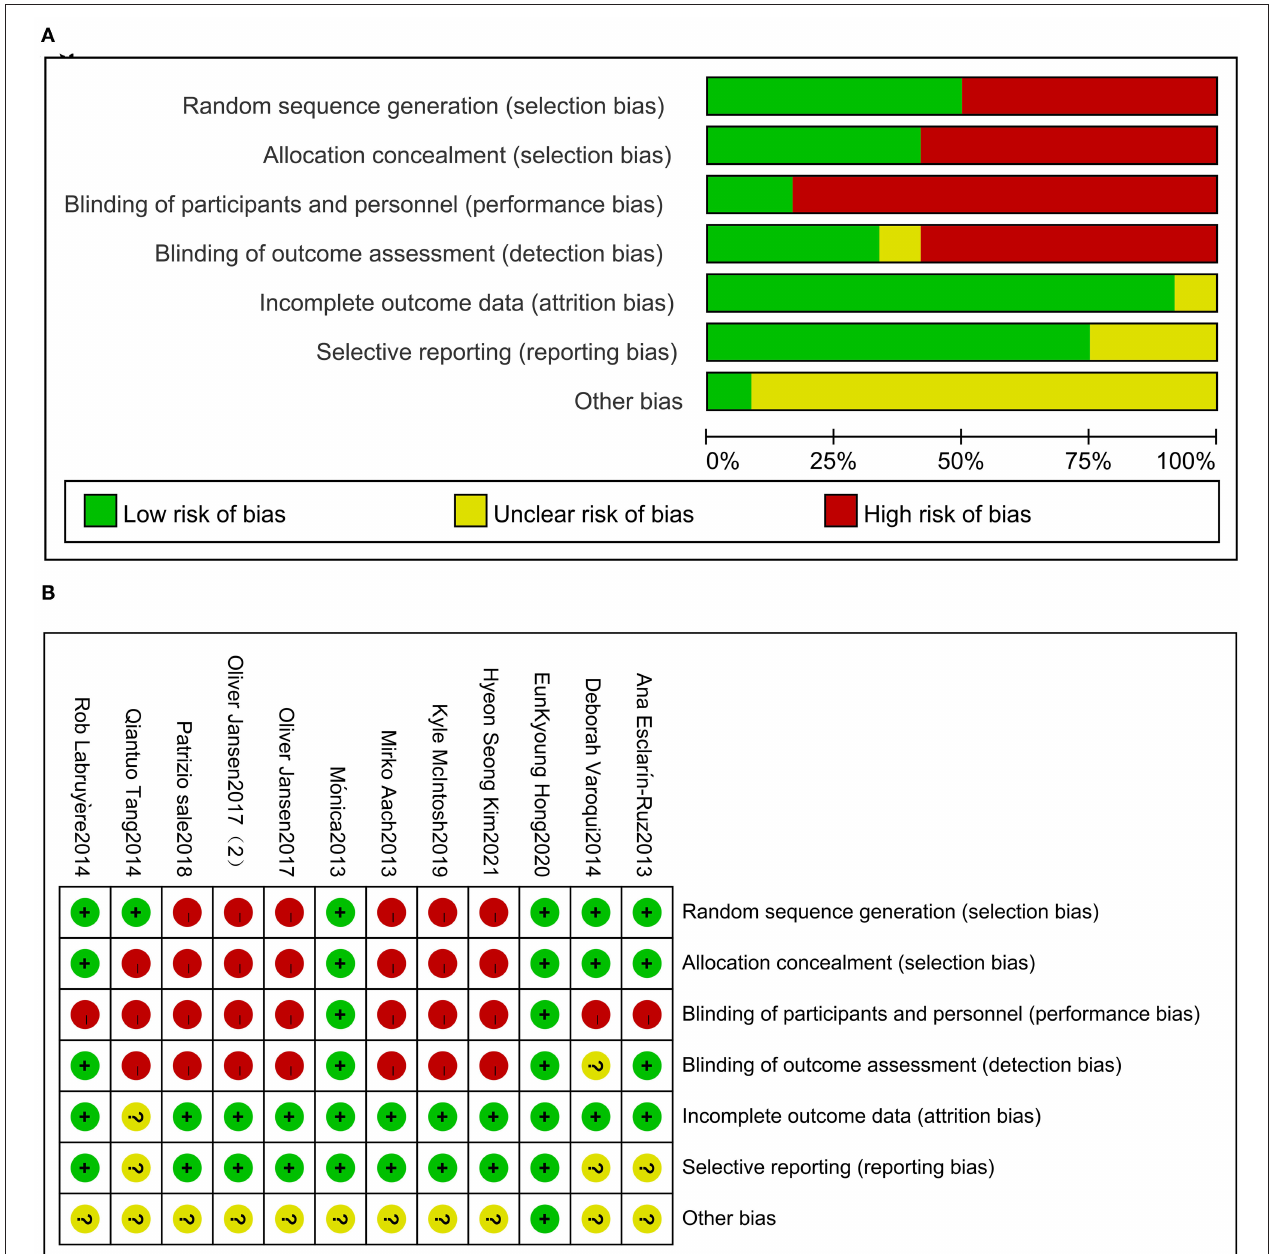
FIGURE 2 | Risk of bias for the included trials (A) . Risk of bias summary for the included trials (B) .